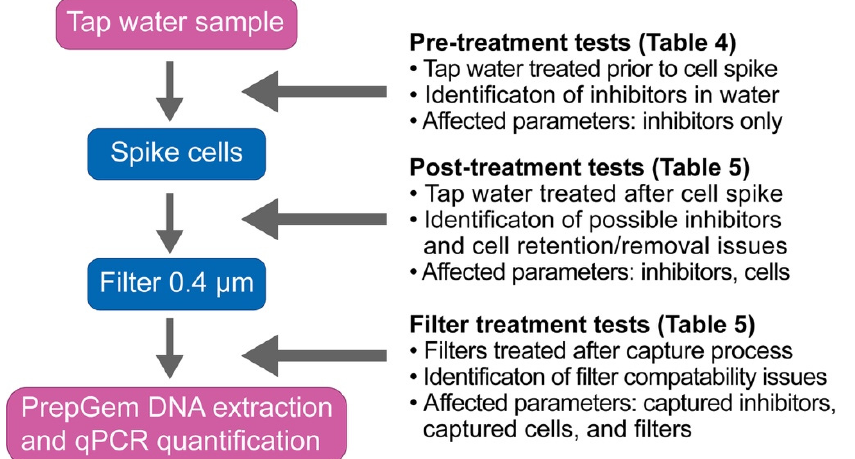
Figure 2. Experimental setup for the three treatment tests against tap water samples: pre-treatment, post-treatment, and filter treatment. Arrows indicate the timing of the application of the corresponding treatments. Table 4. Evaluation of the effectiveness of tap water pre-treatment strategies for the removal of inhibitors in 10 mL samples. TW—tap water in. Treatment process of each sample detailed in corresponding column. * Treatment method resulted in filter